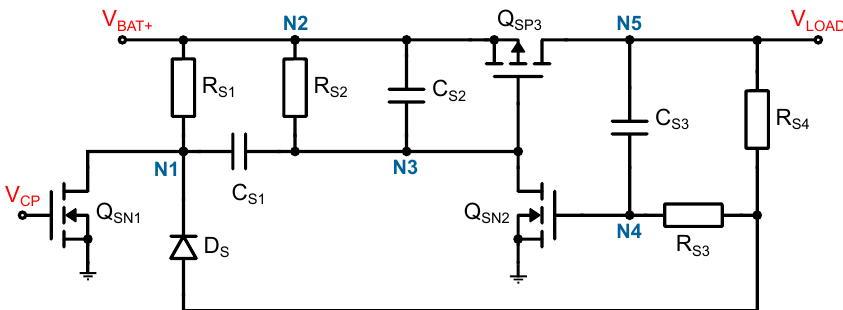
Figure 2. Schematic representation of the latching switch. The transistor Q SP 3 disconnects or connects the battery to the load. The switching command therefor is applied to the gate of Q SN 1 . Table 1. Used components for the latching switch and charge pump. Component Type